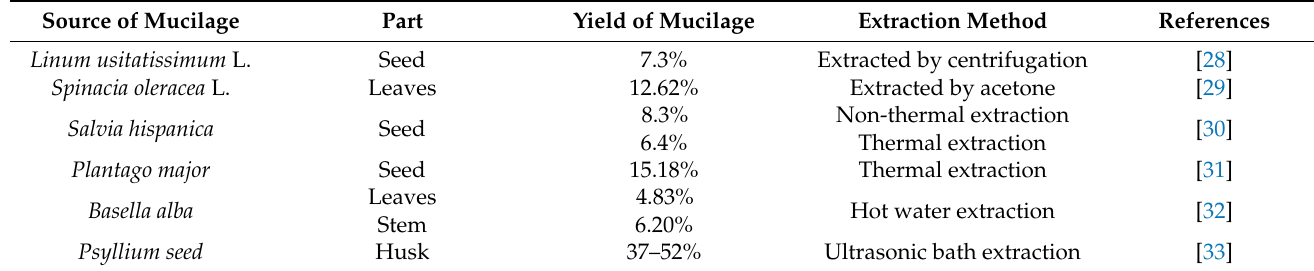
Table 1. Origin of mucilage in different parts of a